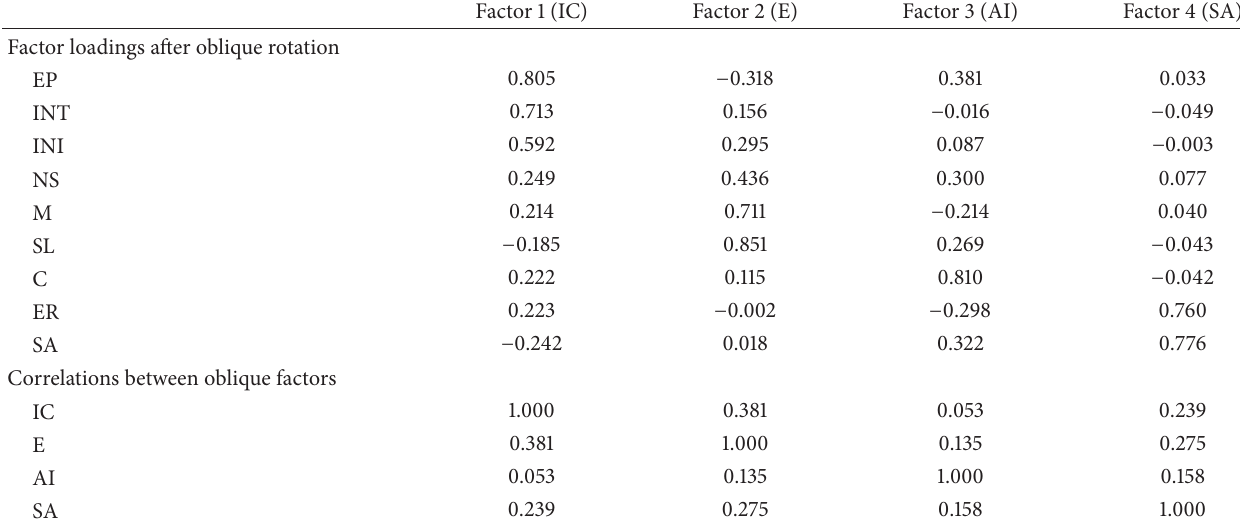
Table 2: Factor loadings after oblique rotation and correlation between oblique factors.